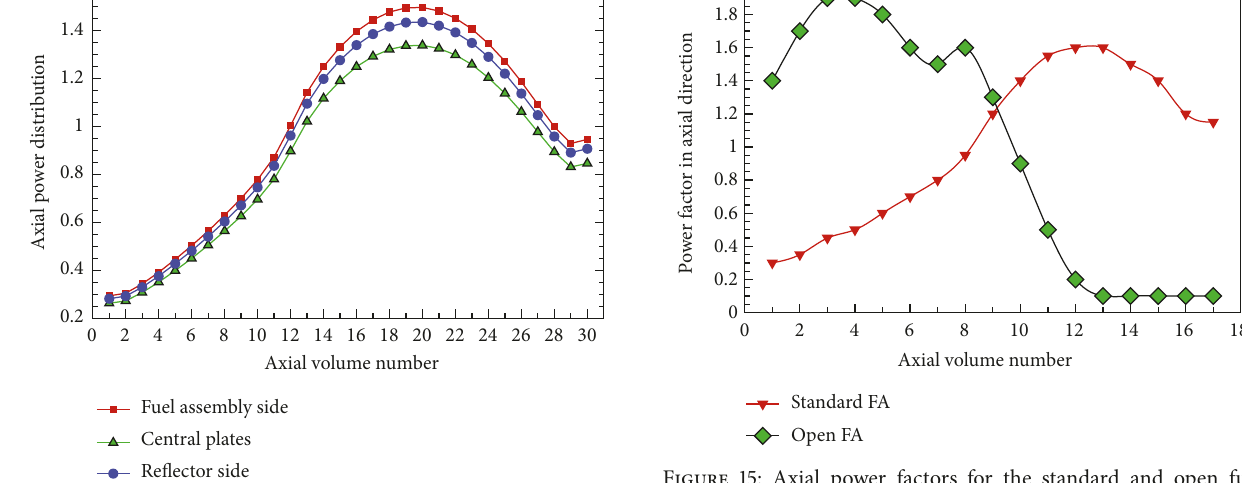
Figure 13: Axial power distribution in the Instrumented Fuel Assembly [26].